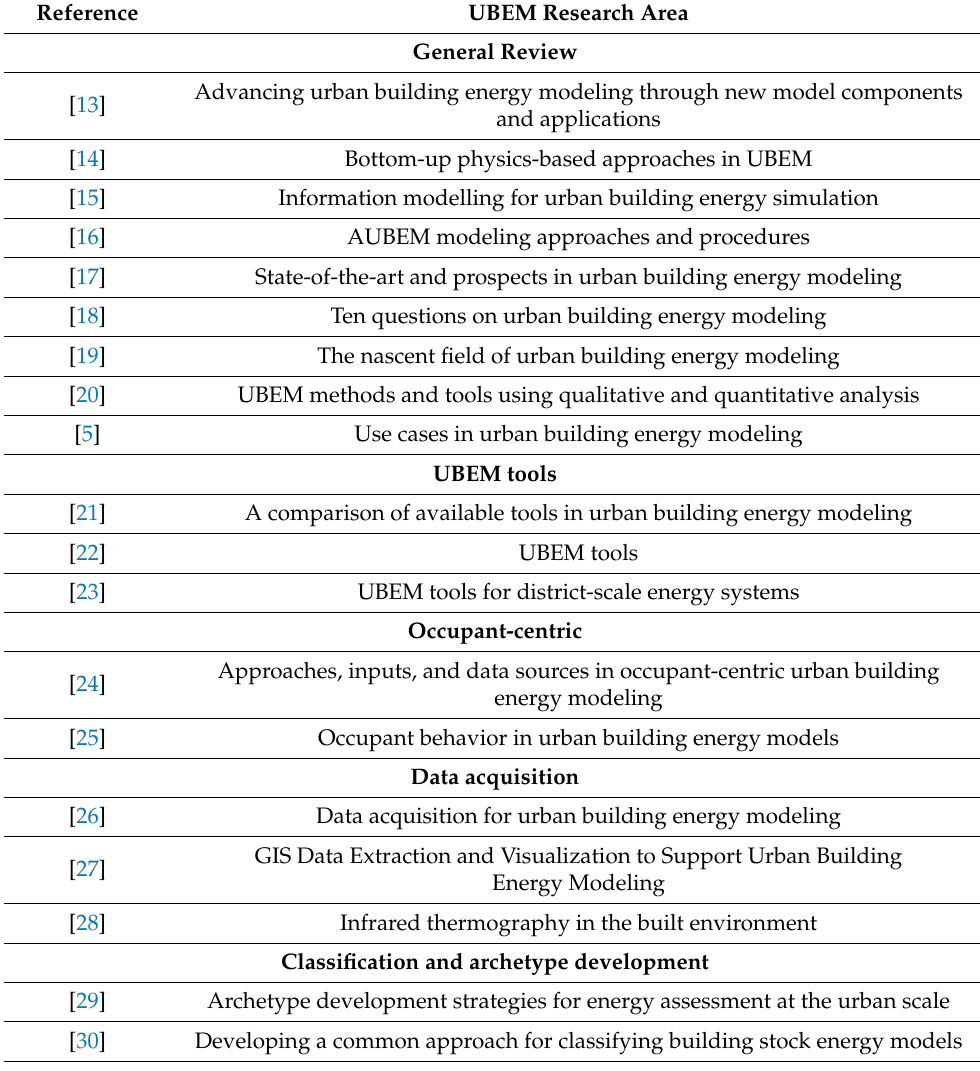
Table 1. Review studies on urban building energy